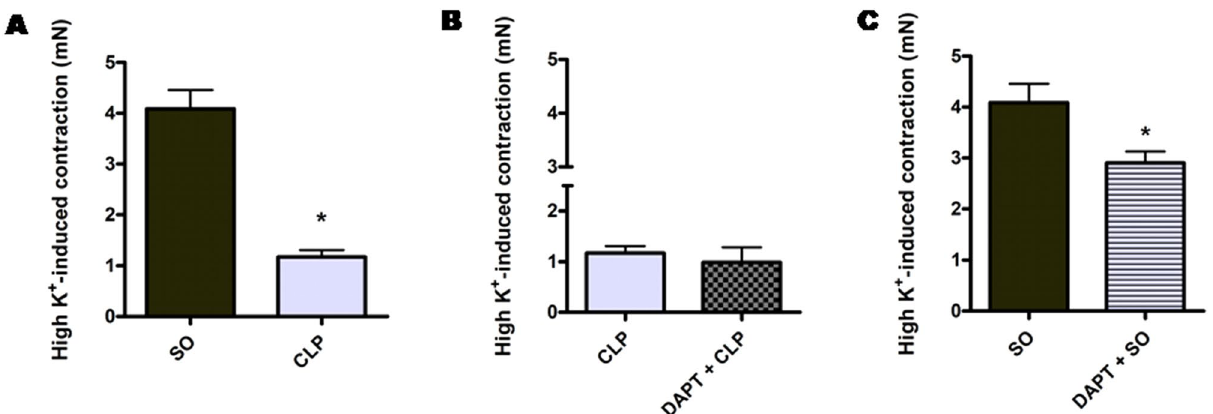
Figure 7. Effect of DAPT pre-treatment on high K + (80 mM) depolarizing solution-induced contraction in aorta of septic mice. Bar diagrams ( A – C ) showing the comparative maximum contraction elicited by high K + (80 mM) solution in the aortic rings isolated from sham-operated (SO), sepsis (CLP), DAPT pre-treated sepsis (DAPT + CLP) and DAPT pre-treated SO (DAPT + SO) groups. Data are presented as mean ± SEM; n = 6. Vertical bars represent SEM. Data were analyzed by unpaired student’s ‘t’ test. * p < 0.05 in comparison to